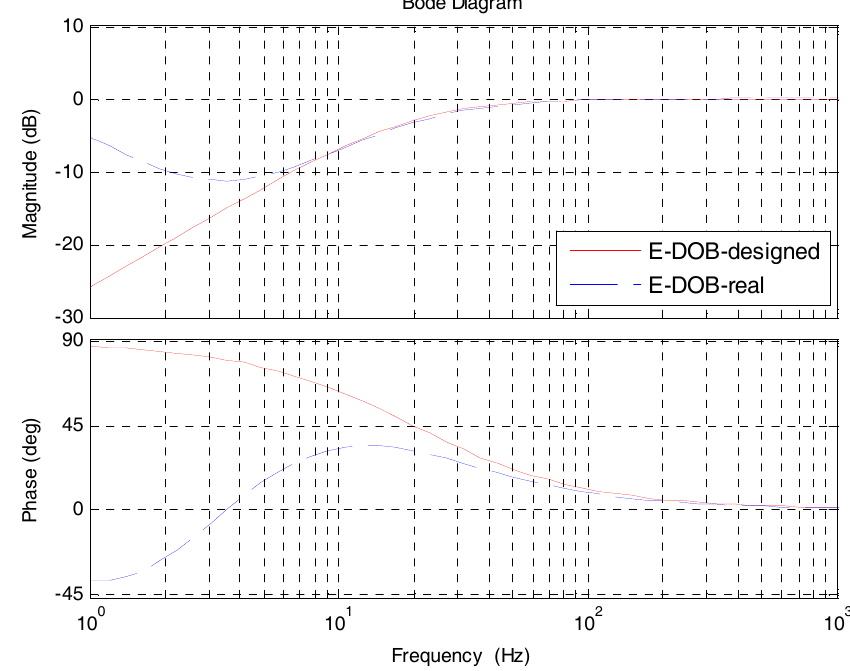
Figure 5. The simulation of E DOB